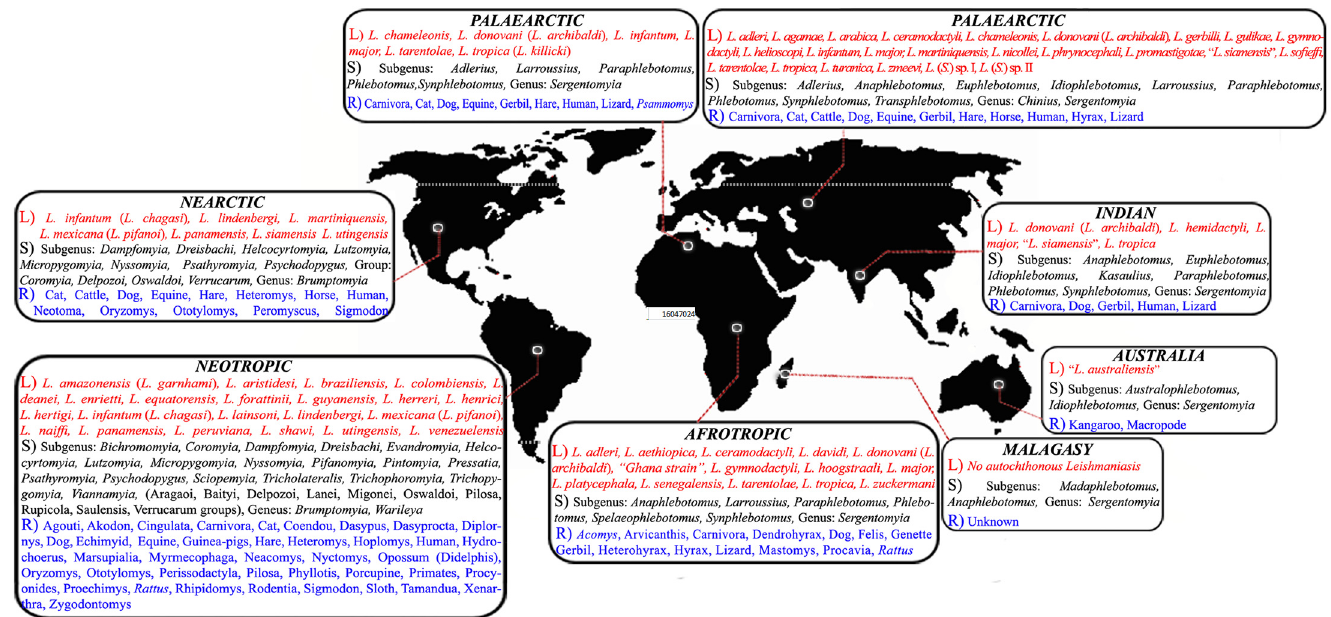
Fig 3. Geographical distributions of various Leishmania spp.; sandflies and animal reservoirs in the Old and New World. L: Leishmania (species), S: Sandfly (genus or subgenus), R: Reservoir (genus or family).